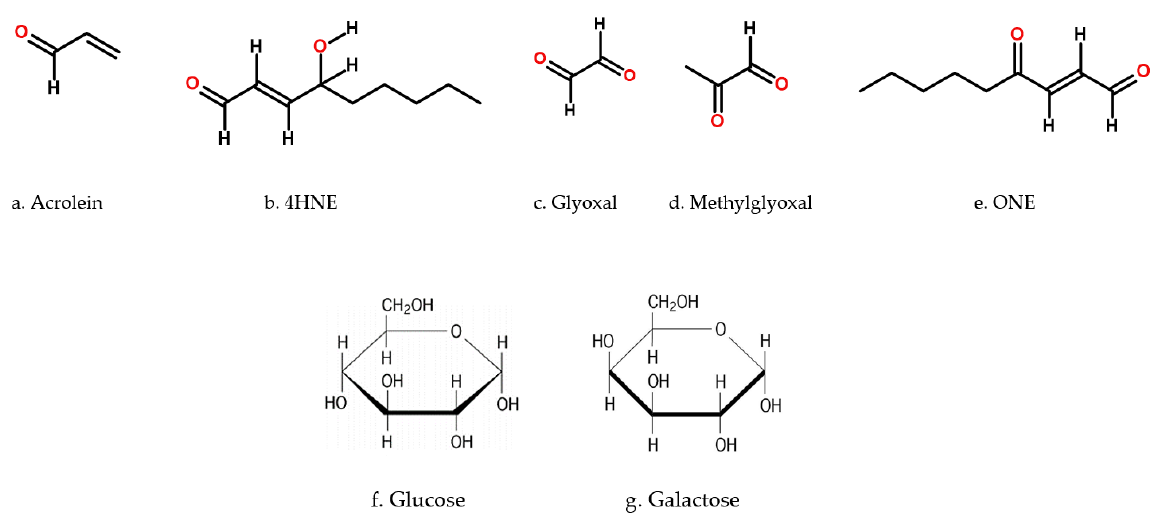
Figure 3. Hyperglycemia induced ‘oxidative-stress’ and its implications. A significant amount of glucose can be shunted